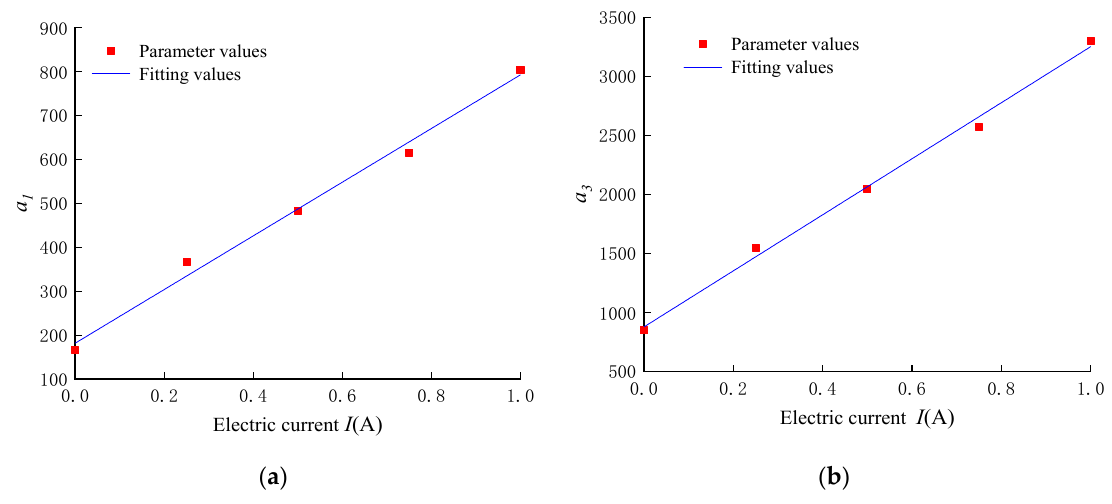
Figure 5. The relation between a 1 , a 3 and current. ( a ) Parameter a 1 , ( b ) parameter a 3 . As shown in Figure 5, parameters a 1 and a 3 are linearly correlated with the current, which can be obtained by linear fitting as shown below: